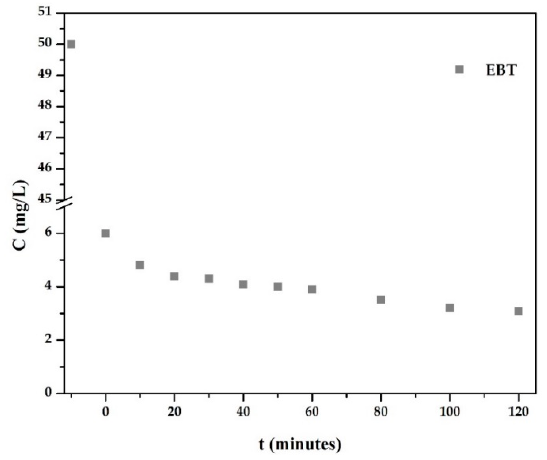
Figure 2. Photocatalytic decomposition of EBT dye.